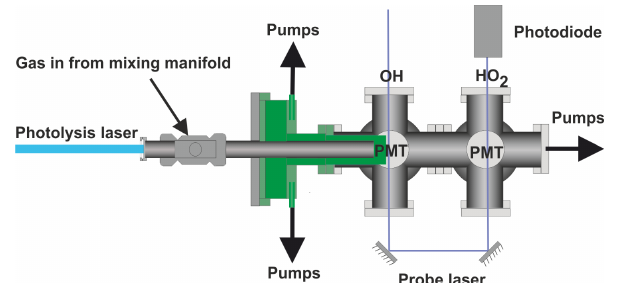
Figure 1. Schematic plan of the apparatus.